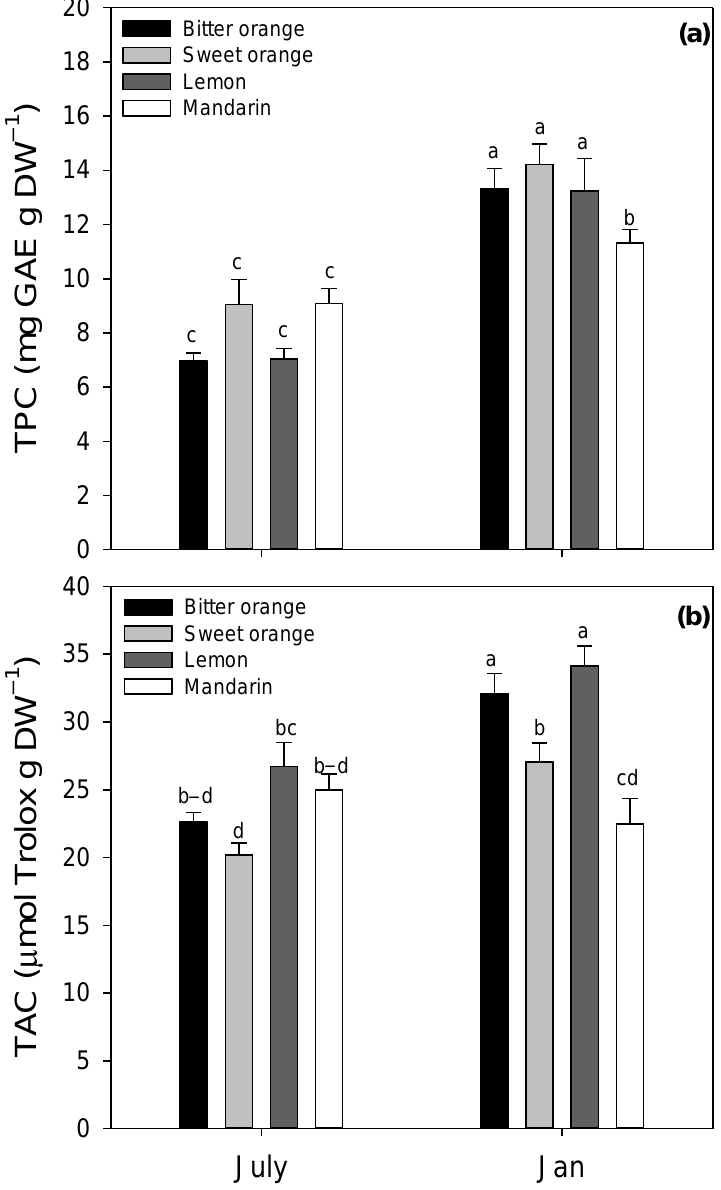
Figure 5. Leaf content of ( a ) total phenolic compounds (TPC, mg GAE g DW − 1 ) and ( b ) total antioxidant capacity (TAC, µ mol Trolox g DW − 1 ) in Citrus spp. in January and July. Data are means ± standard error ( n = 5). Statistics as in Figure 1. Different lowercase letters indicate significant differences among means ( p ≤ 0.05, Fisher’s LSD).